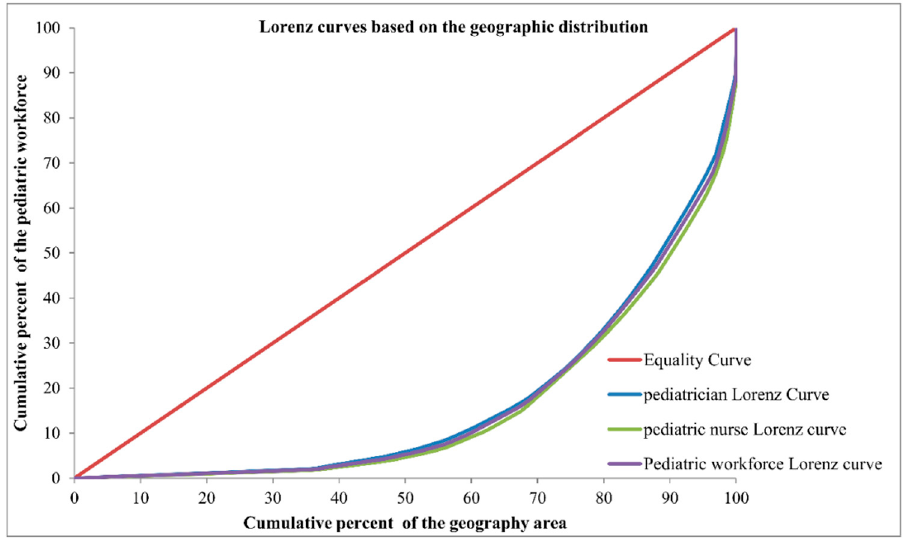
Figure 6. Lorenz curves for the geographic distributions of different indicators.